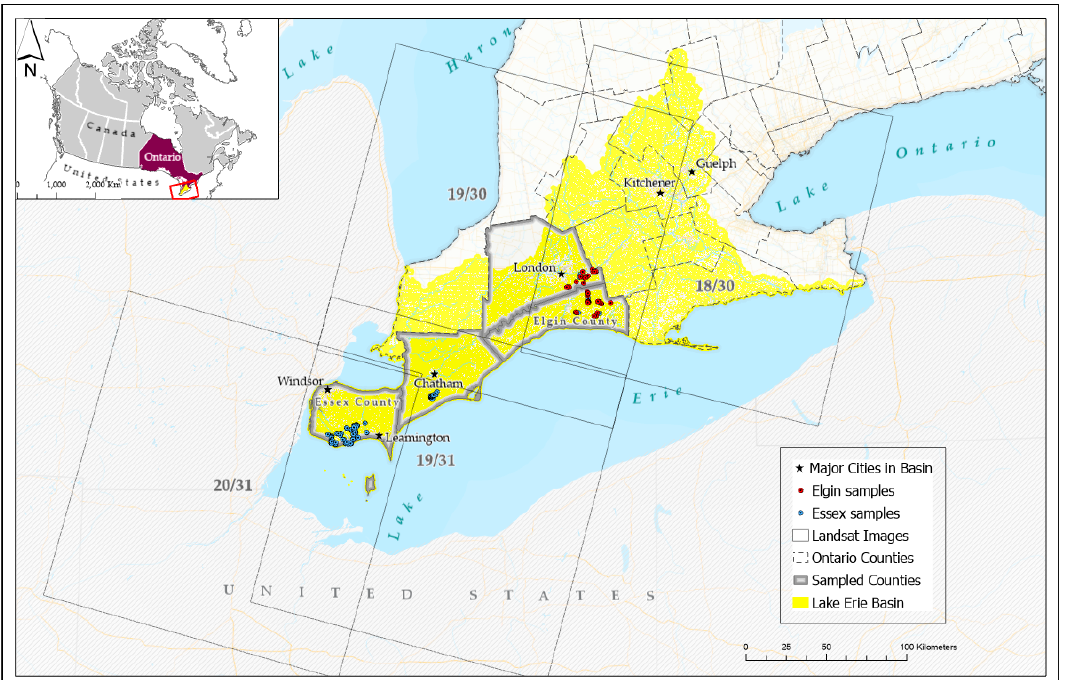
Figure 1. Map of the study area including major cities (black stars) and the Landsat images required to cover the Canadian Lake Erie basin (squares outlined in gray). Numbers in the middle of each image (e.g., 18 / 30) refer to the Landsat path and row, respectively. The same path indicates same day acquisition (e.g., 19 / 31 and 19 /